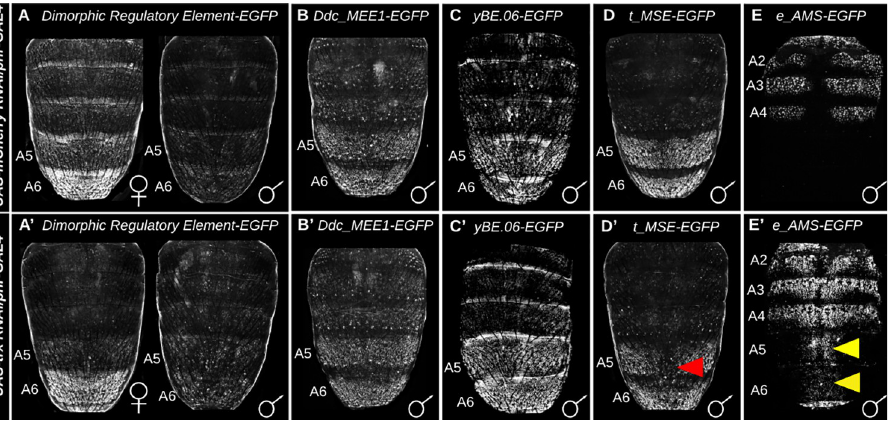
at the P13-14(i) developmental stage. EGFP expression driven by the (D and D’) t_MSE was recorded at the P14-15(i) stage, and (E and E’) e_AMS CRE’s activity were recorded at 2 hours after eclosion. All specimens are hemizygous for the EGFP reporter transgene. Yellow arrowheads indicate segments where the genetic background alterations resulted in conspicuous ectopic EGFP reporter expression. Red arrowheads indicate segments where the genetic background alterations resulted in a reduced EGFP reporter